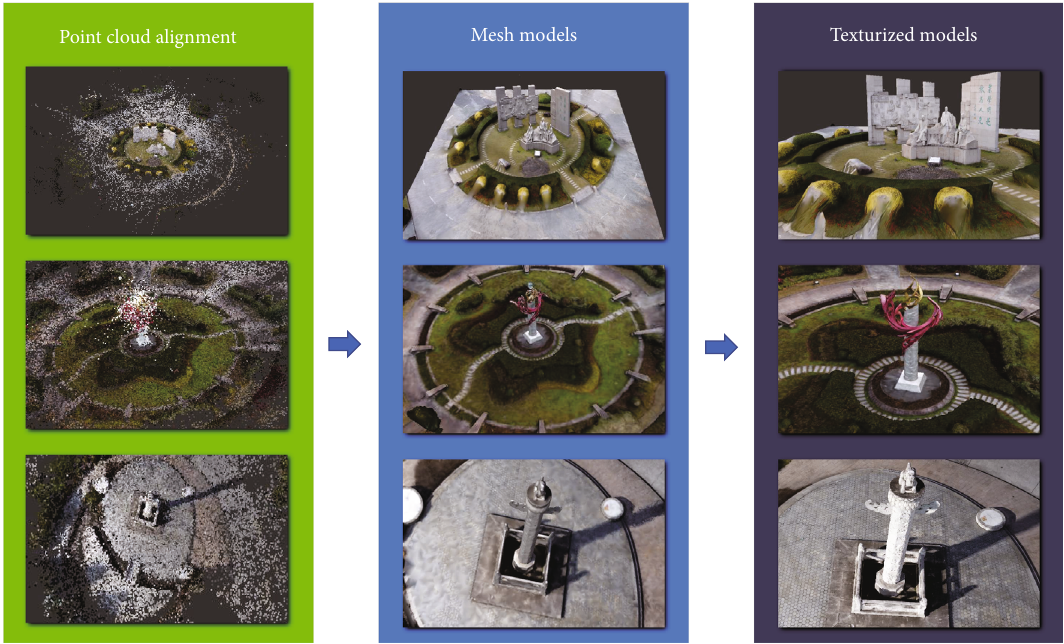
Figure 7: The reconstructed e ff ect of